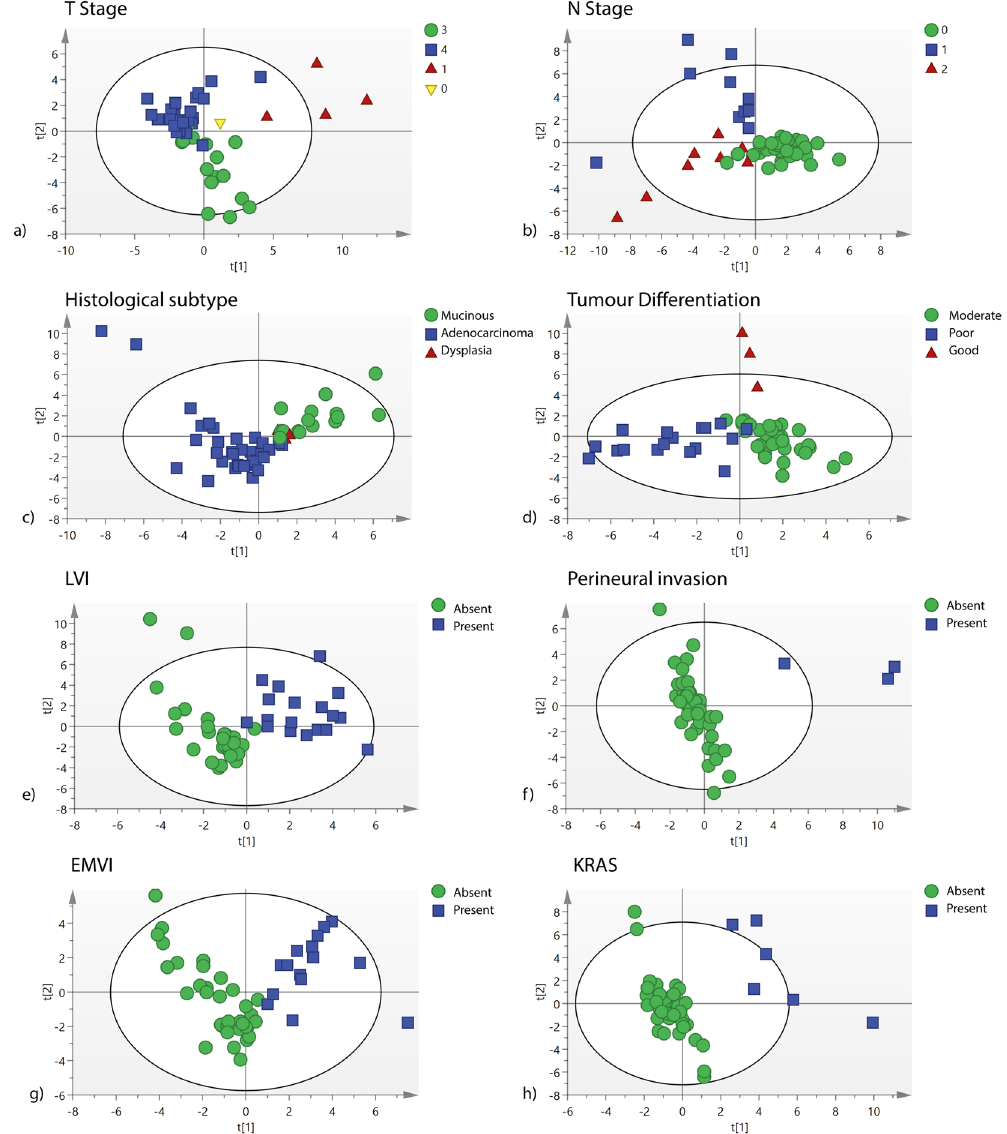
Figure 3. ( a – h ) Partial Least Squares-discriminant analysis scores plots of OTU data for important prognostic features identified by histopathological and molecular analysis. LVI = Lymphovascular invasion. EMVI = Extramural vascular invasion. PNVI = Perineural vascular